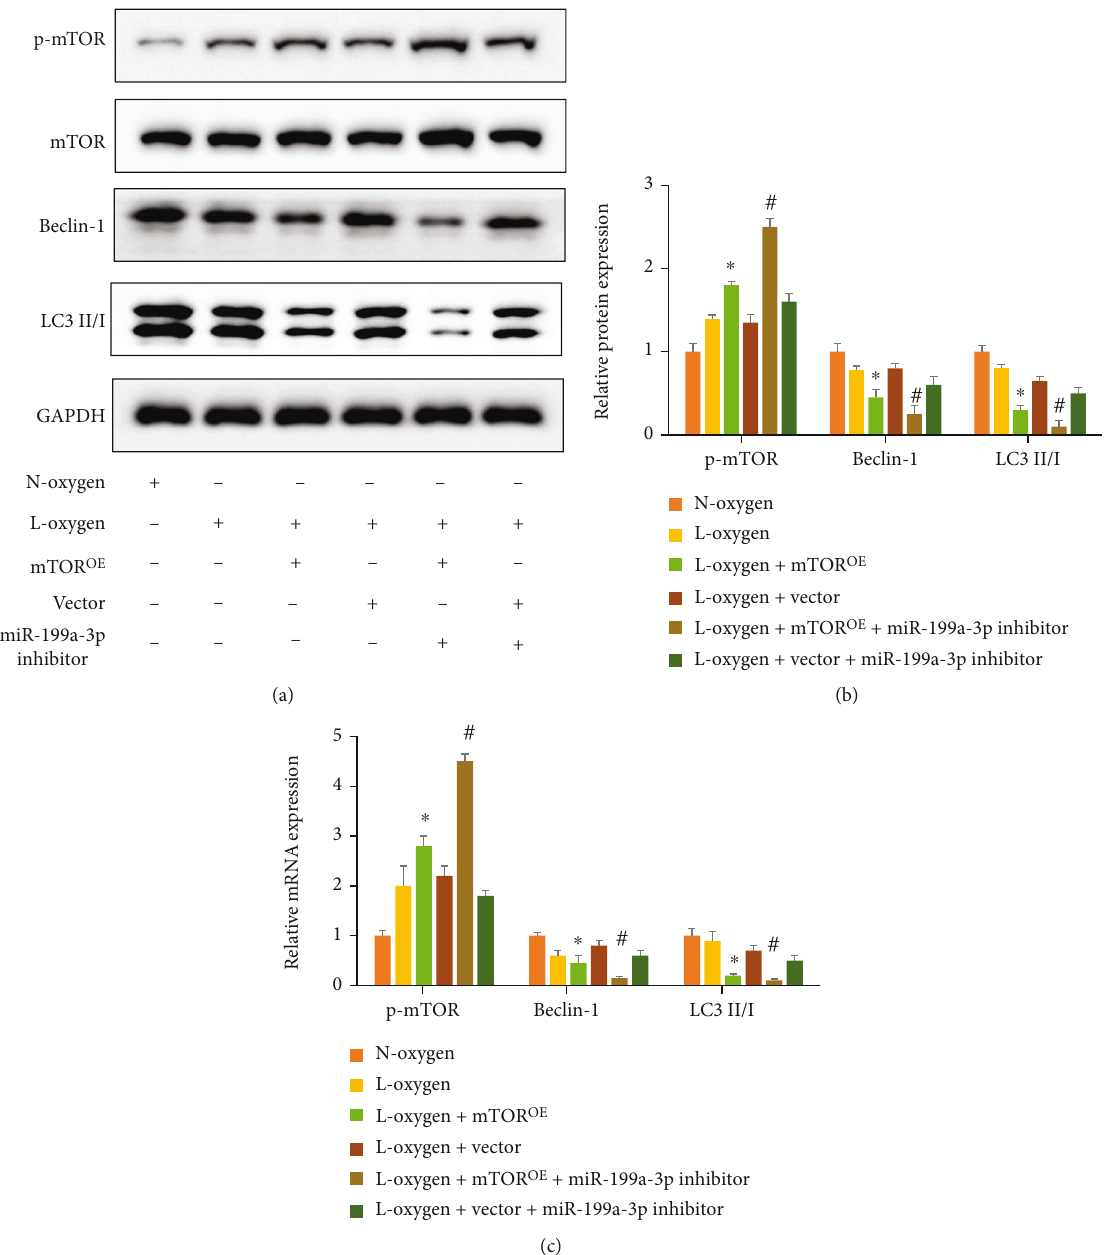
Figure 5: Overexpression of mTOR or miR-199a-3p inhibitor markedly inhibited autophagy. (a) The protein expression levels were evaluated via western blotting. (b) Protein levels were quanti fi ed. (c) The mRNA expression was detected with qRT-PCR. ∗ P < 0 : 05 compared to group L-oxygen. # P < 0 : 05 compared to group L-oxygen+mTOR OE